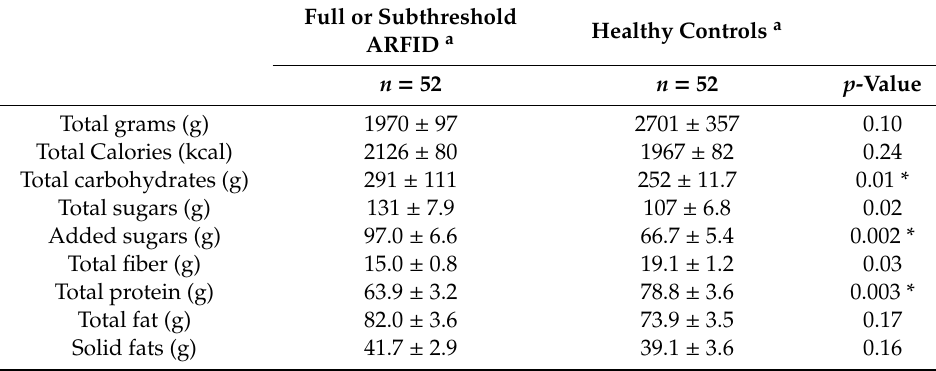
Table 5. Mean energy and macronutrient intake in participants with full or subthreshold ARFID and healthy controls.